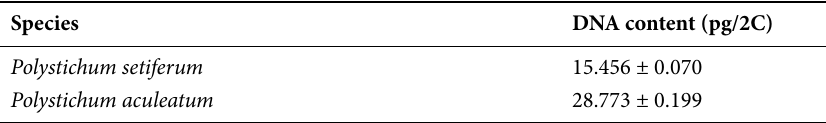
Table 2 DNA content (pg/2C) of the investigated Polystichum species from Mt Czupel in the Beskid